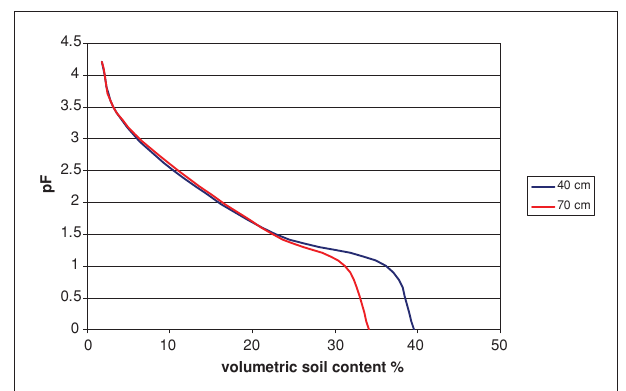
Figure 2: The pF curves of the examined sandy soils in 40 and 70 cm depth